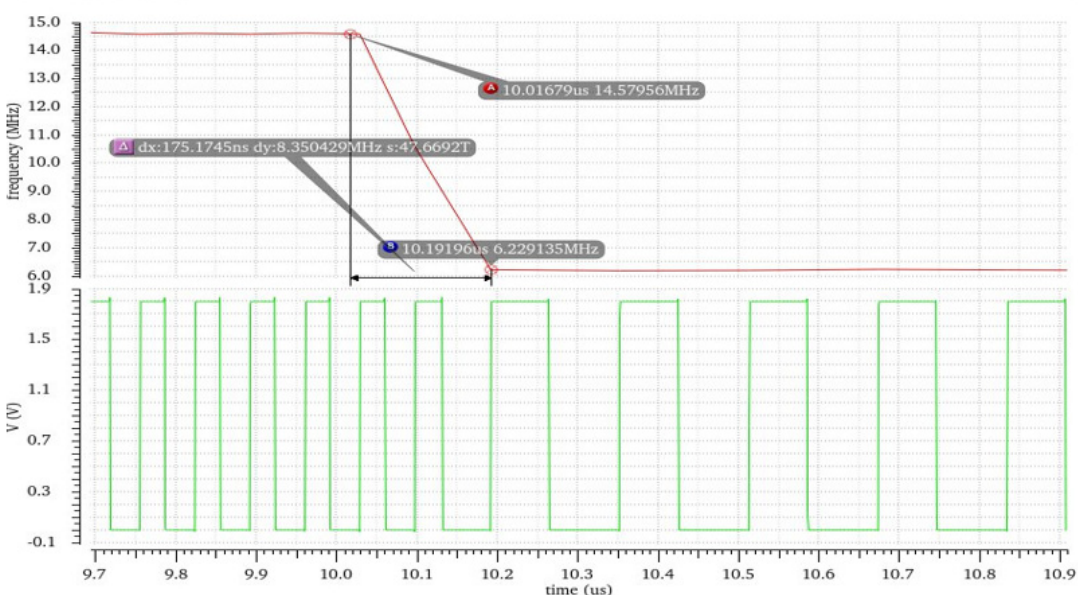
Figure 14. The simulation results of the current-hungry voltage control oscillator.